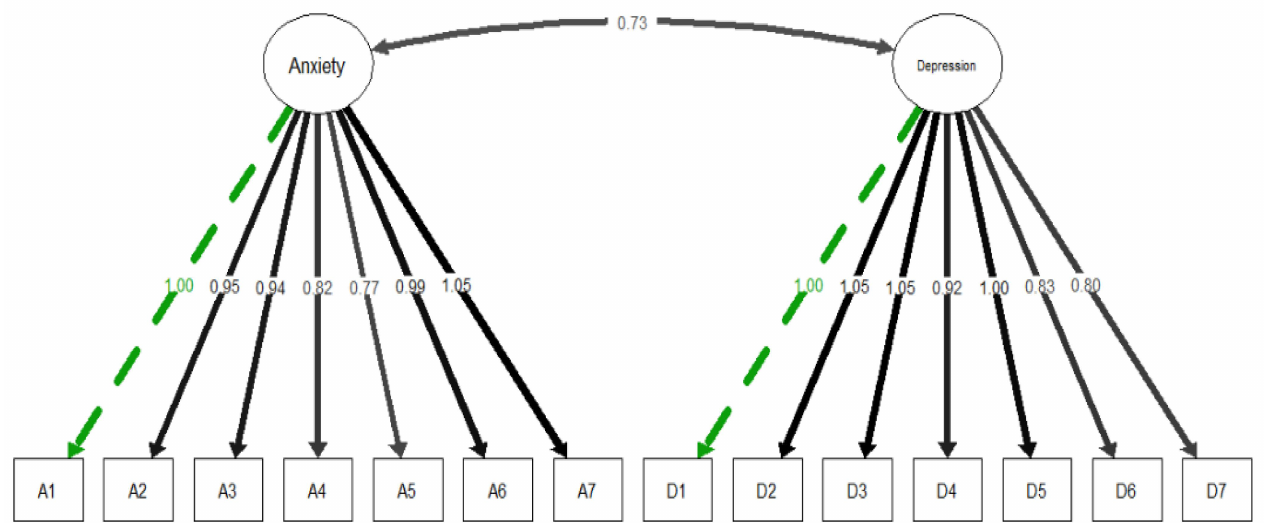
Figure 3. Structural equation modeling (SEM) of the Hospital Anxiety and Depression Scale (HADS) in COVID-19 survivors. Dotted line indicates fixed loading. Items of anxiety subscale (A1, A2, A3, A4, A5, A6, A7). Items of depression subscale (D1, D2, D3, D4, D5, D6,